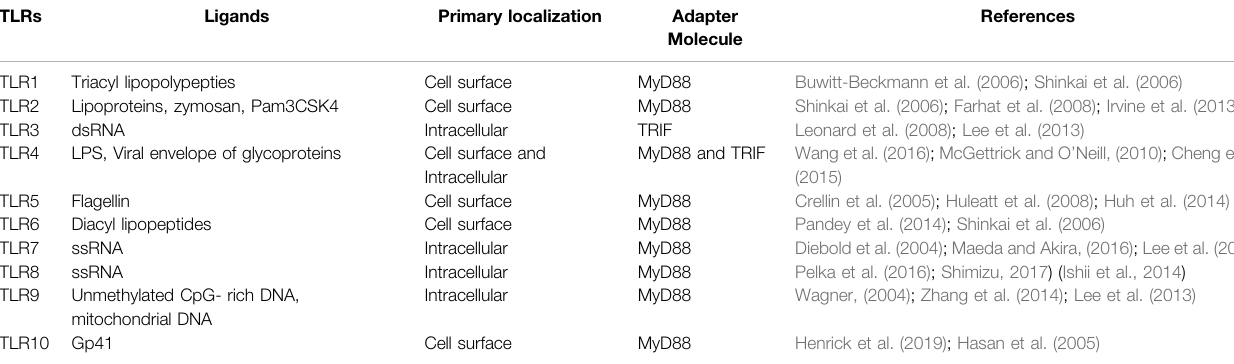
TABLE 3 | TLRs, their ligands, cellular localization, and the adaptor